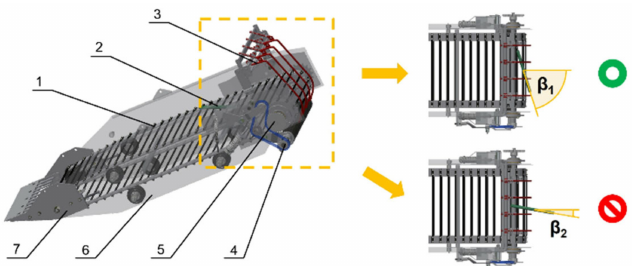
Figure 2. Schematic diagram of the structure and failure situation of the picking roller stem re- mover. 1. Separating rod sieve; 2. Potato stem; 3. Stem guide bar; 4. Grooved stem picking roller; 5. Separating rod sieve active shaft; 6. Rack; 7. Excavation